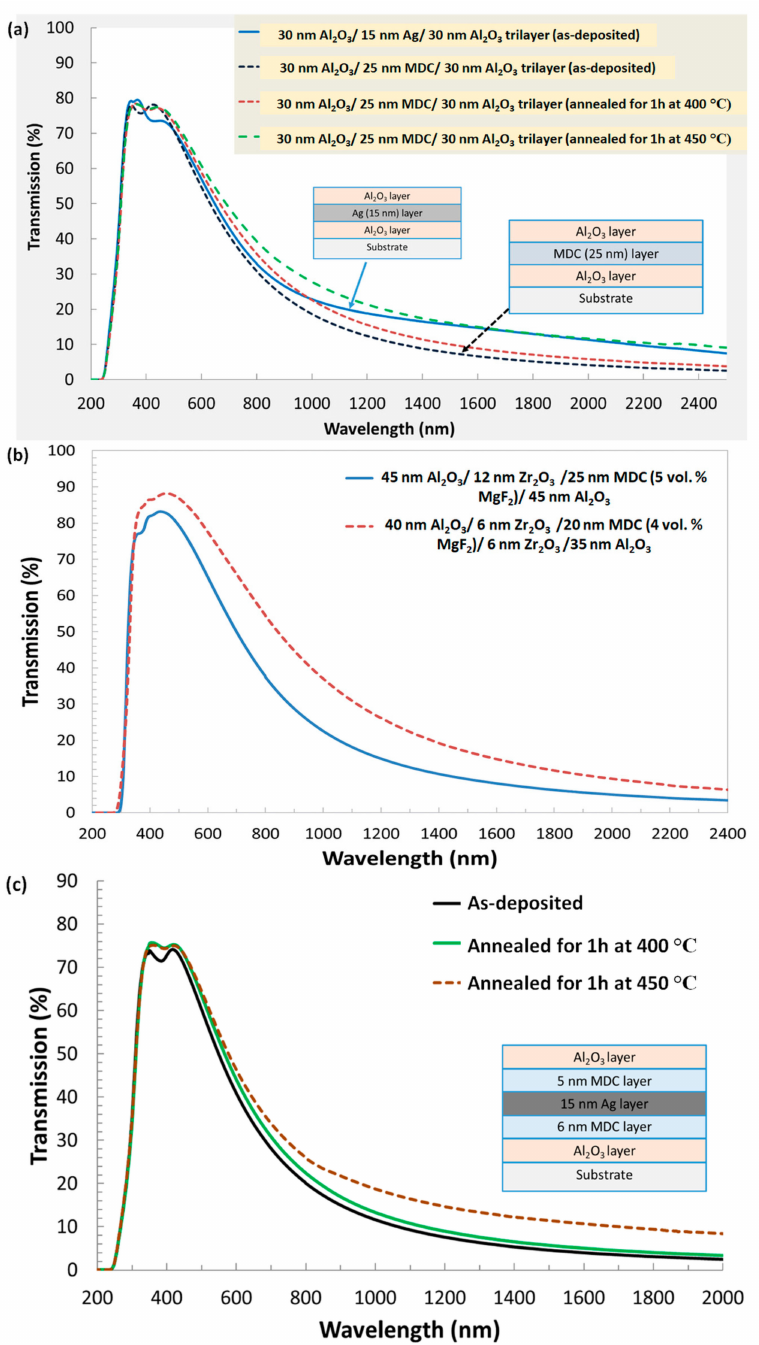
Figure 10. Measured transmission spectra of multilayer thin-film structures containing a single (or double) metallic or MDC layer. ( a ) Transmission of a trilayer MDC structure compared to that of a typical Ag layer within a dielectric–metal–dielectric (DMD) structure; thermal performance stability test results are also shown for the trilayer MDC structure; ( b ) transmission spectra of multilayer structures containing MDC layer of di ff erent volumetric fractions of added dielectric; and ( c ) thermal performance stability test results for a complex DMD-type multilayer structure containing both the MDC outer-bracket sublayers and an ultrathin pure-Ag core